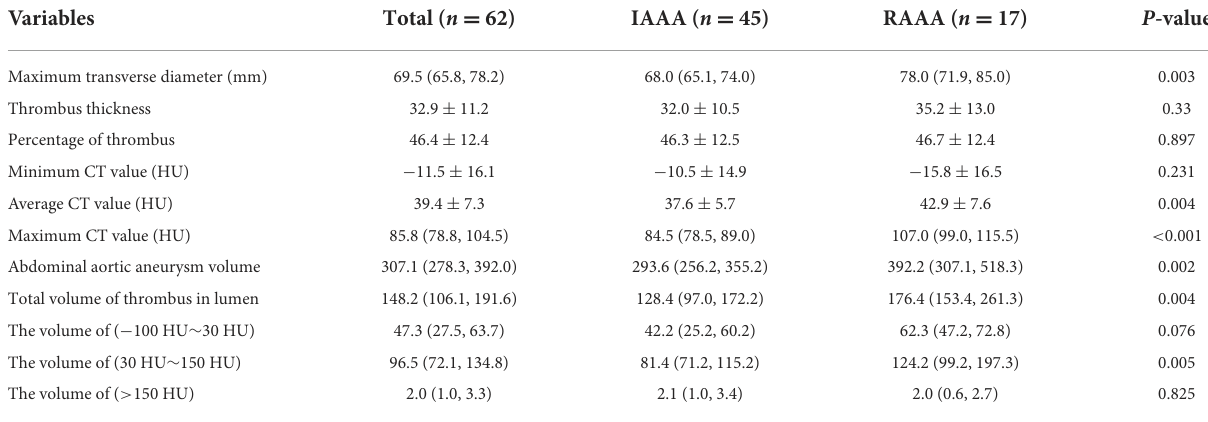
TABLE 2 Aneurysm lumen and thrombus in intact and ruptured abdominal aortic aneurysms.